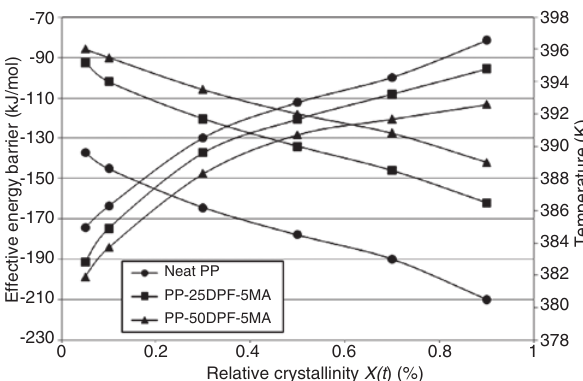
Figure 9: Dependence of the effective activation energy and temperature on the relative crystallinity for neat polypropylene (PP) and its date palm fiber (DPF)